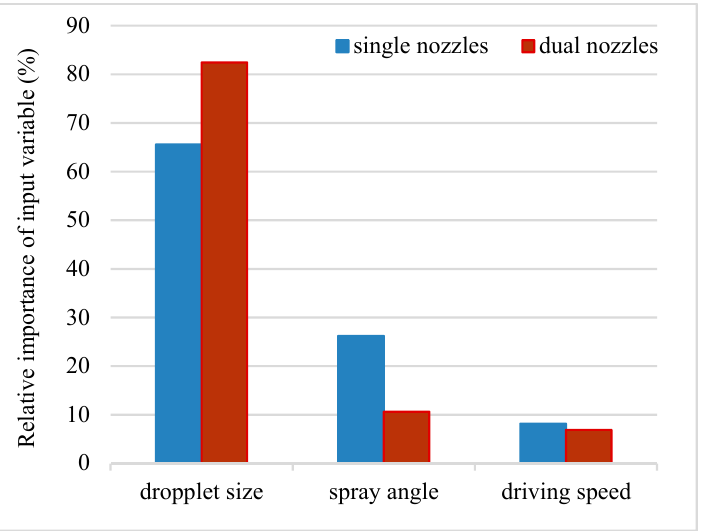
Figure 9. The relative importance of the input variables of the MLP model on the coverage unevenness coefficient. The analysis of experimental data shows that in the case of single nozzles, the highest value of an average degree of coverage was observed for small droplet size (182.4 µ m— produced by a single standard flat-fan nozzle with a pressure of 400 kPa), low driving speed (1.1 m · s − 1 ), and nozzle angular position of − 20 ◦ . On the other hand, the lowest value of the coverage unevenness coefficient was produced by medium droplet size (400 µ m—obtained from a single air-induction flat-fan nozzle with a pressure of 300 kPa), high driving